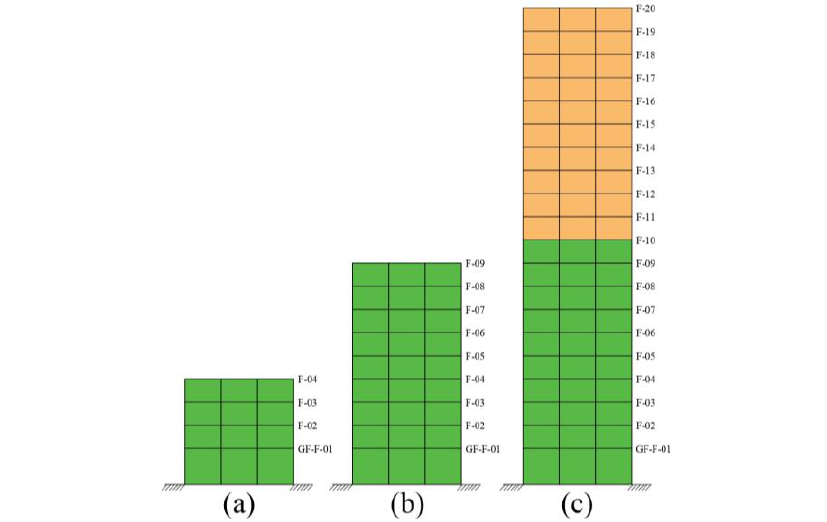
Fig. 1. General concept of time period depend on height.